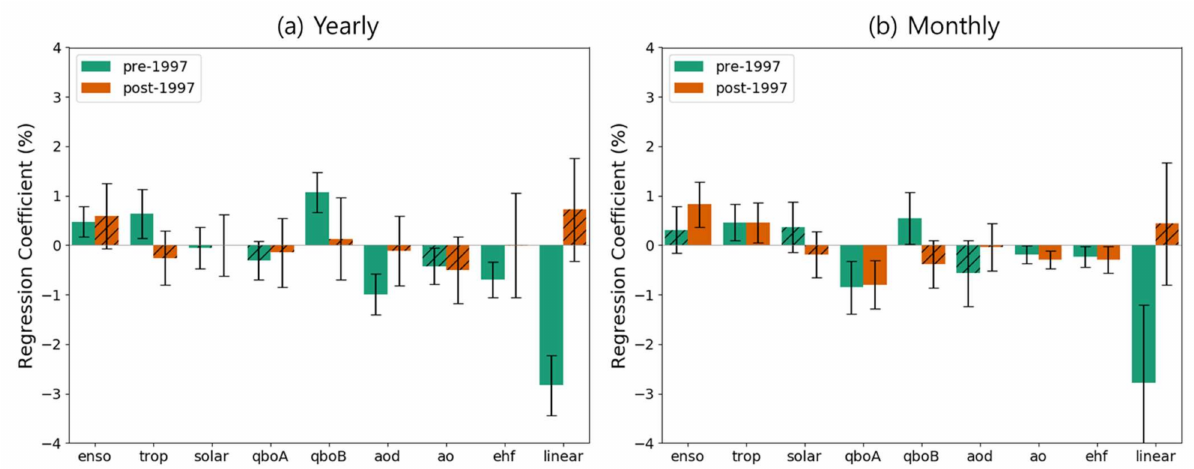
Figure 3. Normalized regression coefficients with 2-sigma error bars for each proxy from the yearly ( a ) and monthly ( b ) MLR analysis using SBUV MOD averaged over 35–40 ◦ N. The proxies with a p -value > 0.05 are presented as shaded